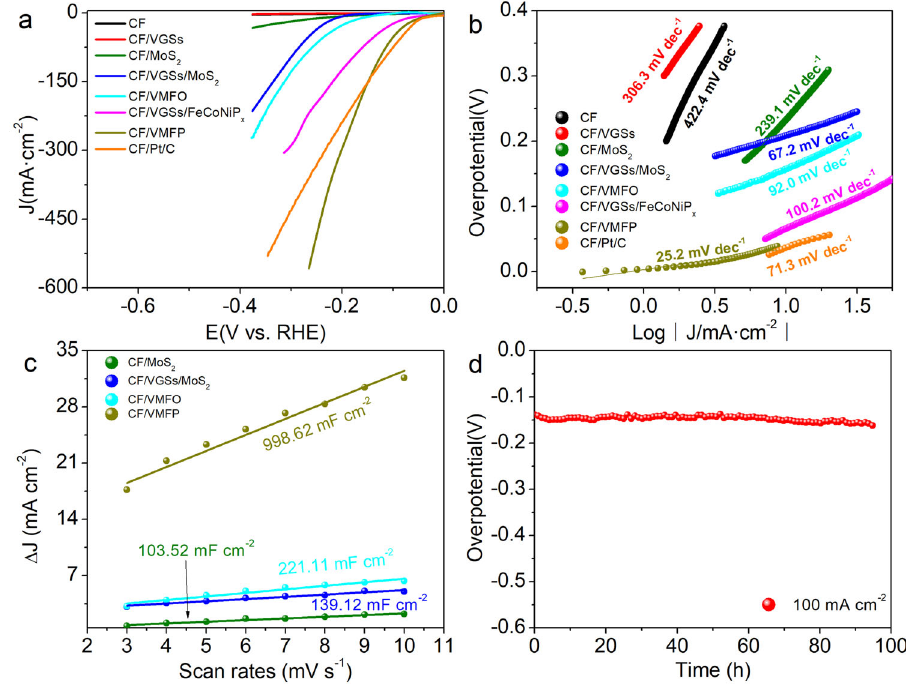
Fig. 7 HER performance of different samples tested in 1 M KOH. a LSV curves. b Tafel plots. c Capacitive currents at different scan rates. d Time- dependent overpotential curves of CF/VMFP at 100 mA/cm 2